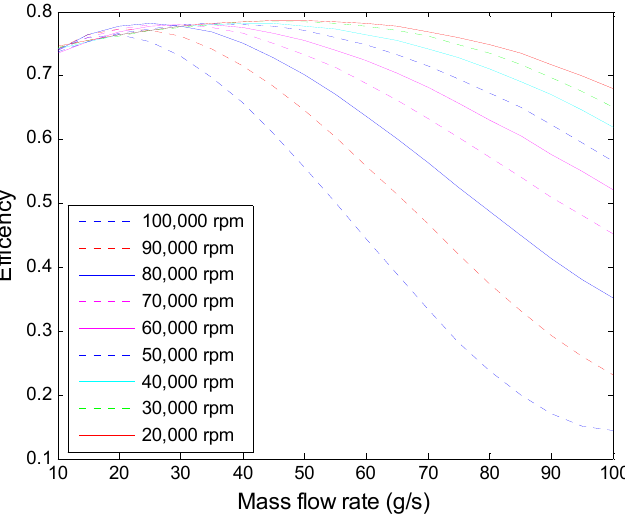
Figure 6. Efficiency–flow curve of the air compressor.